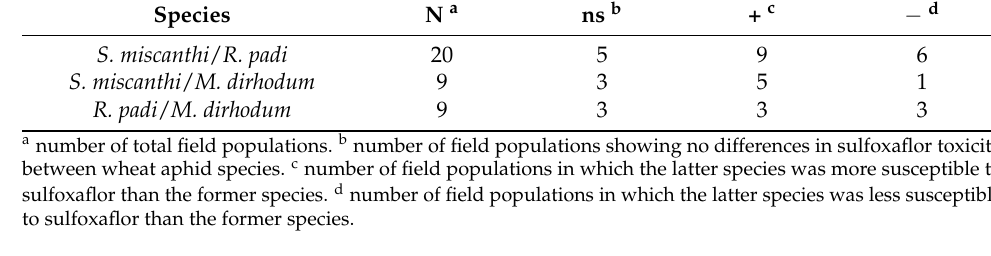
Table 4. The differences in sulfoxaflor toxicity between wheat aphid species. Species N a ns b + c − d S. miscanthi / R. padi 20 5 9 6 S. miscanthi / M. dirhodum 9 3 5 1 R. padi / M. dirhodum 9 3 3